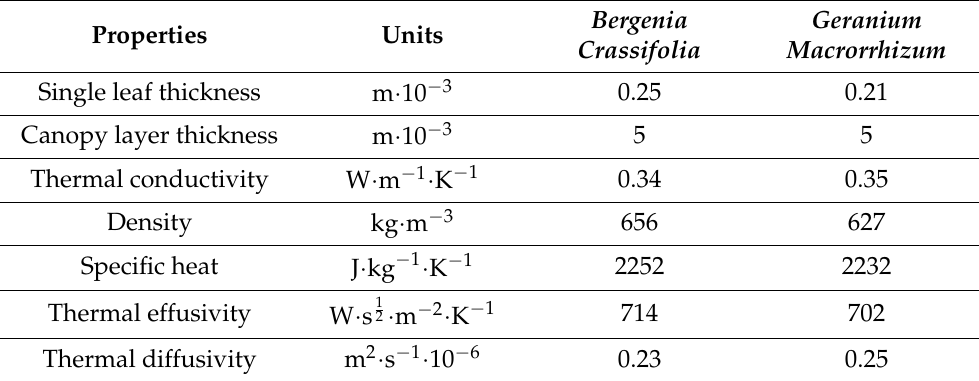
Table 3. Variation range for the variable parameters that influence solar absorptance coefficient and related references.